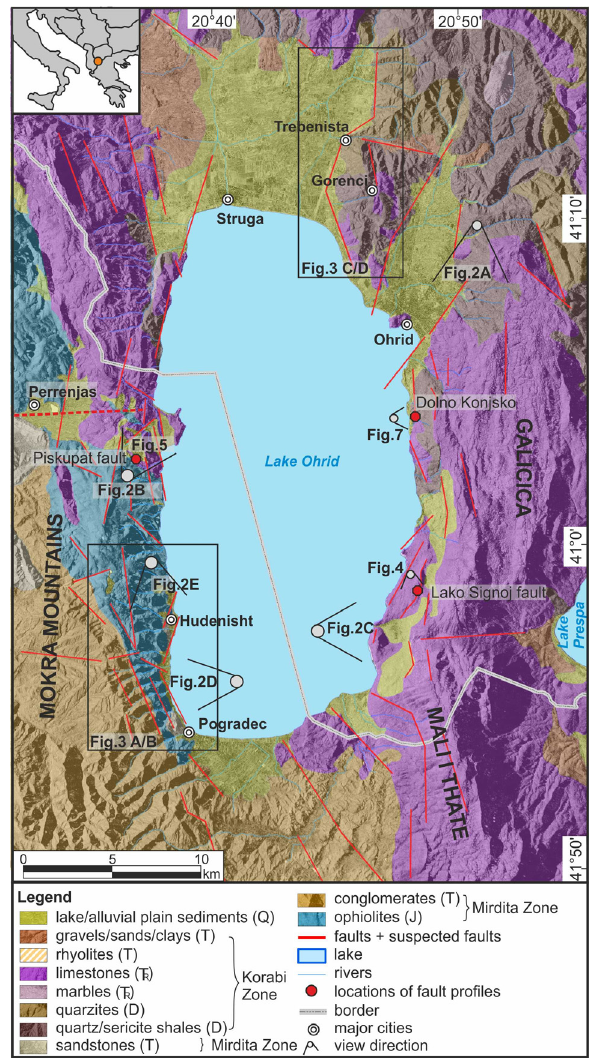
Figure 1. Overview and lithological map of Lake Ohrid including locations of figures. Compiled after Dumurdzanov and Ivanovski [1977], Premti and Dobi